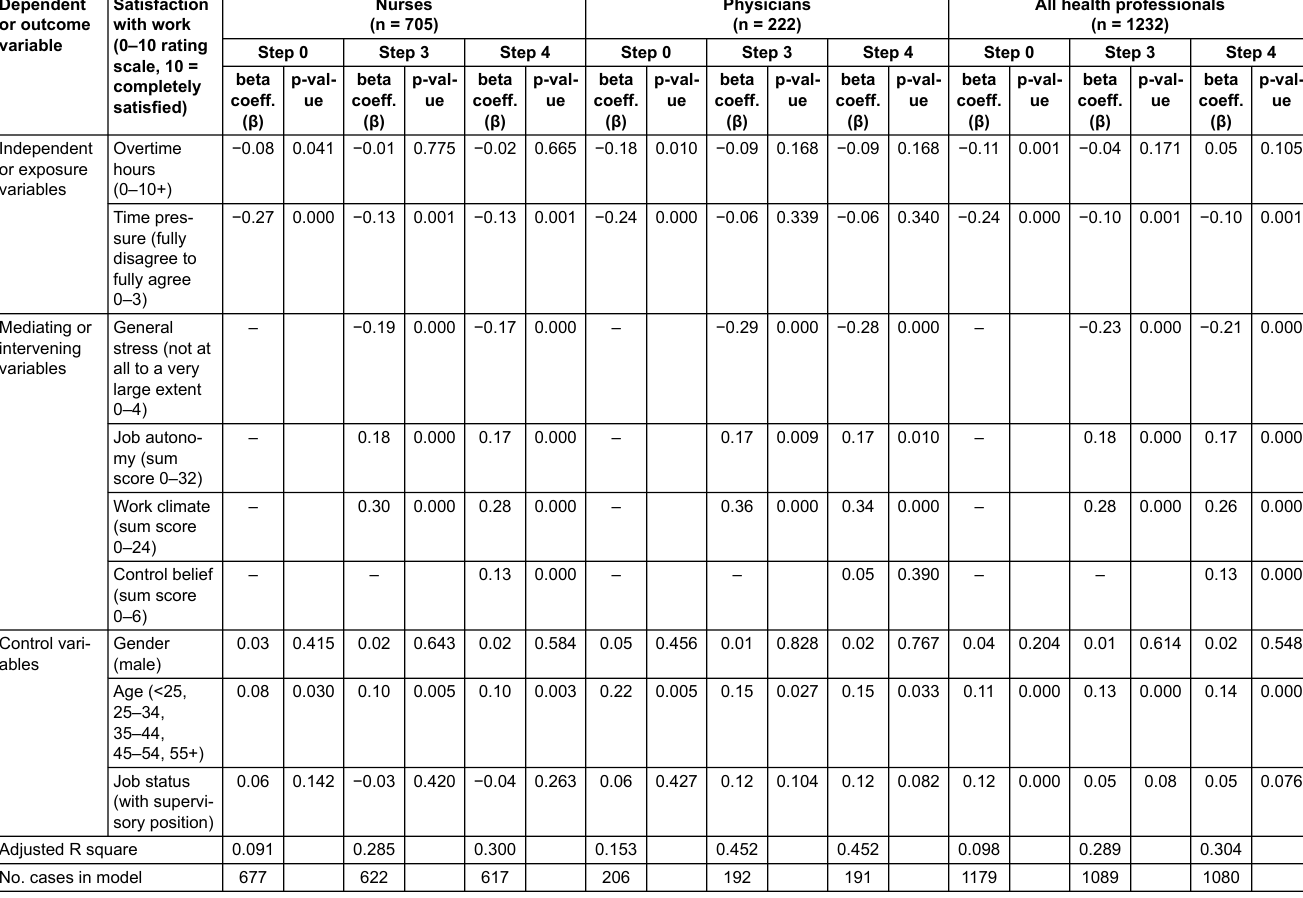
Table 4a: Explaining job satisfaction among health professionals – results of a stepwise multiple regression analysis (step 0, steps 3 and 4) Dependent Satisfaction or outcome with work variable